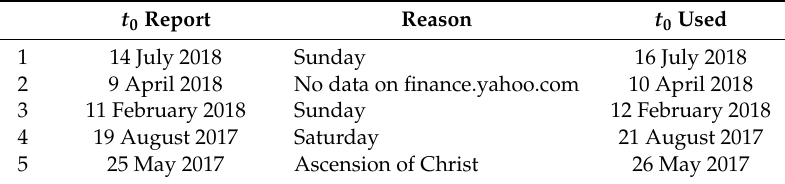
Table A2. CSR-relevant notifications on non-trading days.